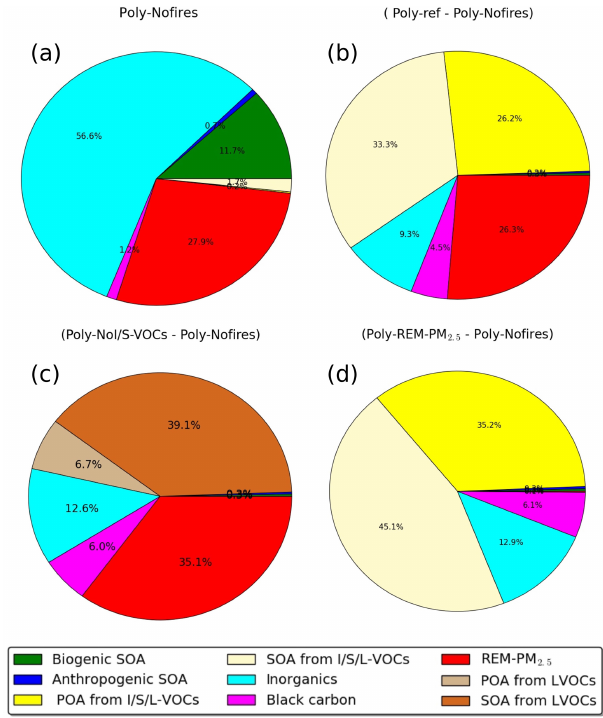
Figure 5. Composition of surface PM 2 . 5 concentration over MedReg1 during the first fire event ( a simulation Poly-Nofires). Composition of surface PM 2 . 5 concentration due to fires ( b simu- lation Poly-ref; c simulation Poly-noI/S-VOCs; d simulation Poly- NoREM-PM 2 . 5 ).